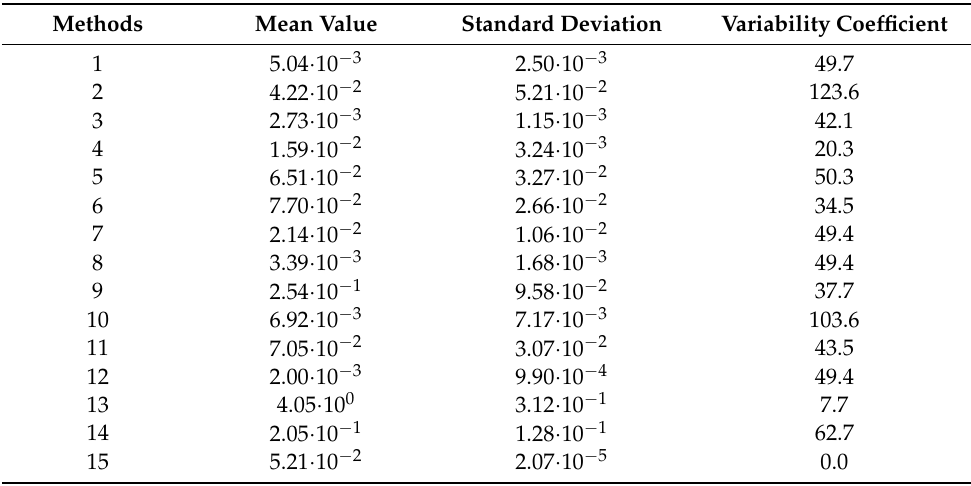
Table 8. Values of parameters of spatial